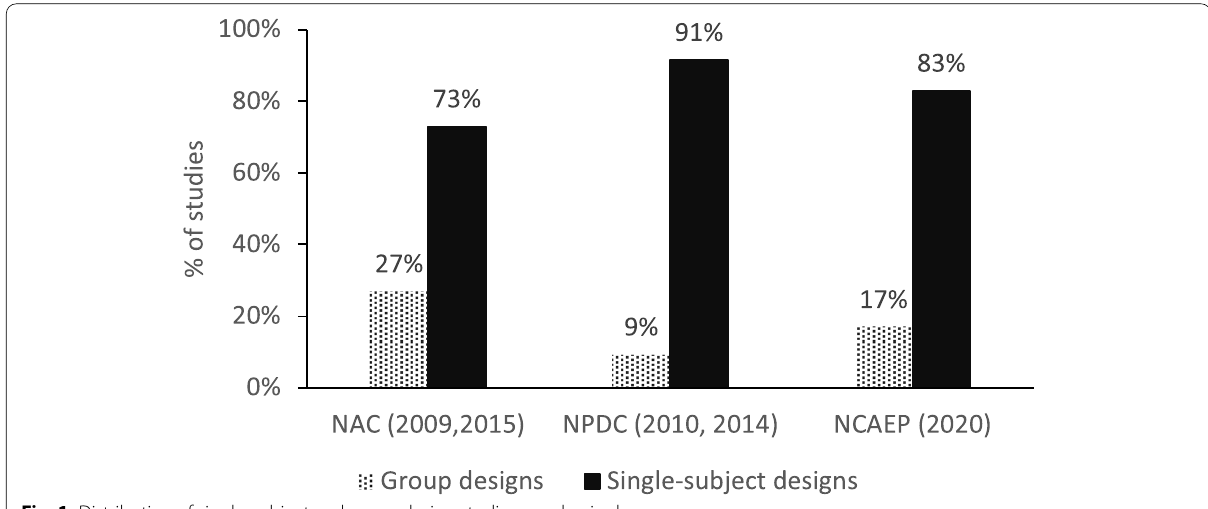
Fig. 1 Distribution of single-subject and group design studies per